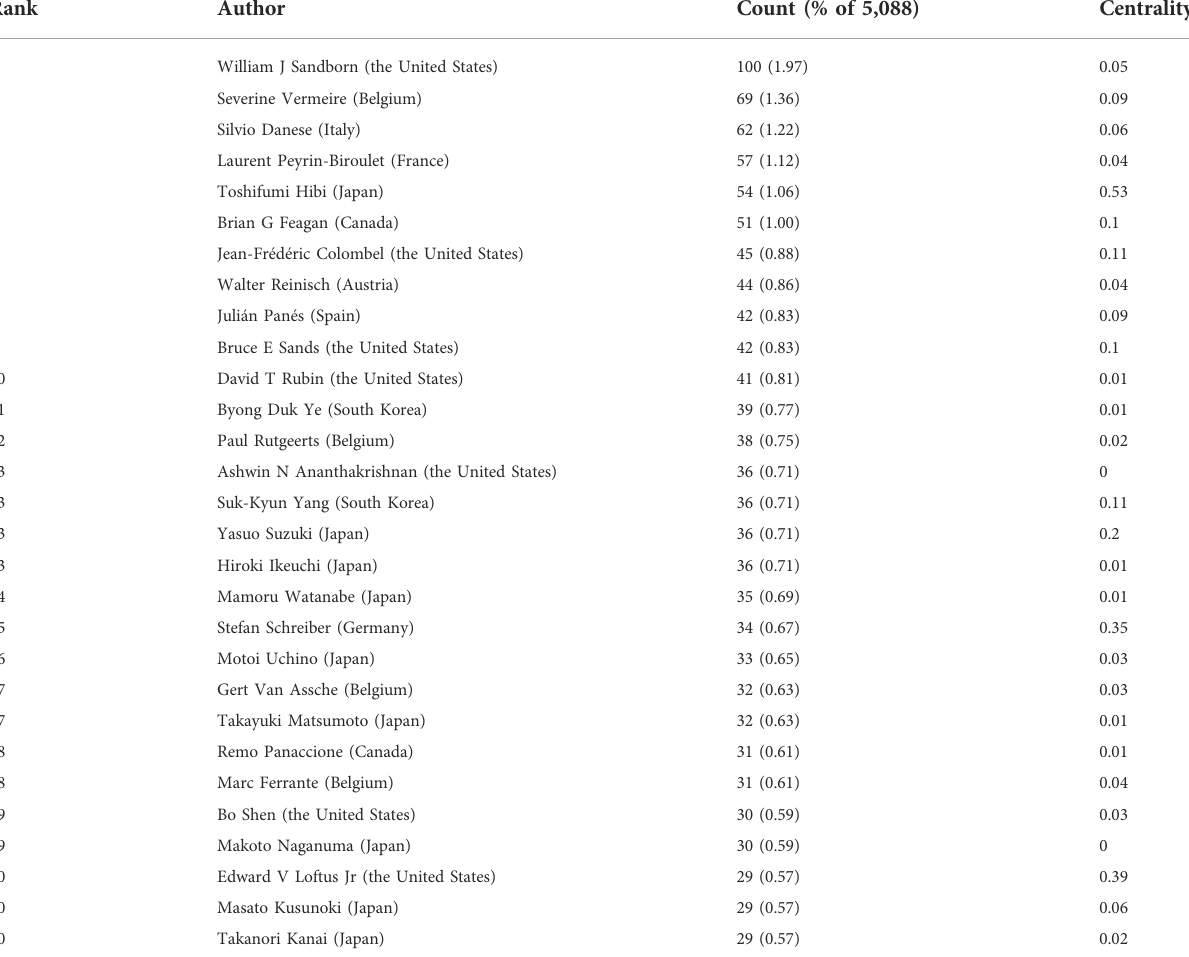
TABLE 3 Top productive 20 authors in UC